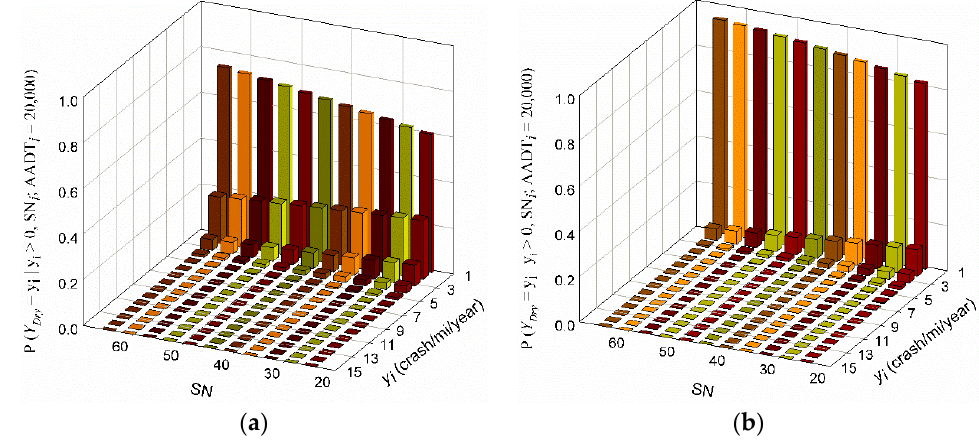
Figure 10. Probability mass function under varying SN and fixed AADT for ( a ) dry and ( b ) wet fitted models.